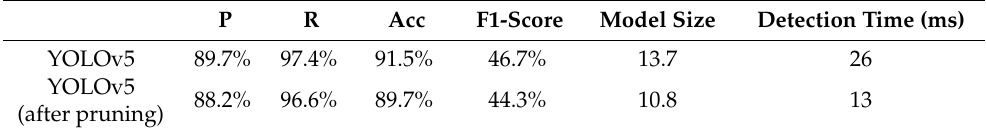
Table 4. Comparison results before and after